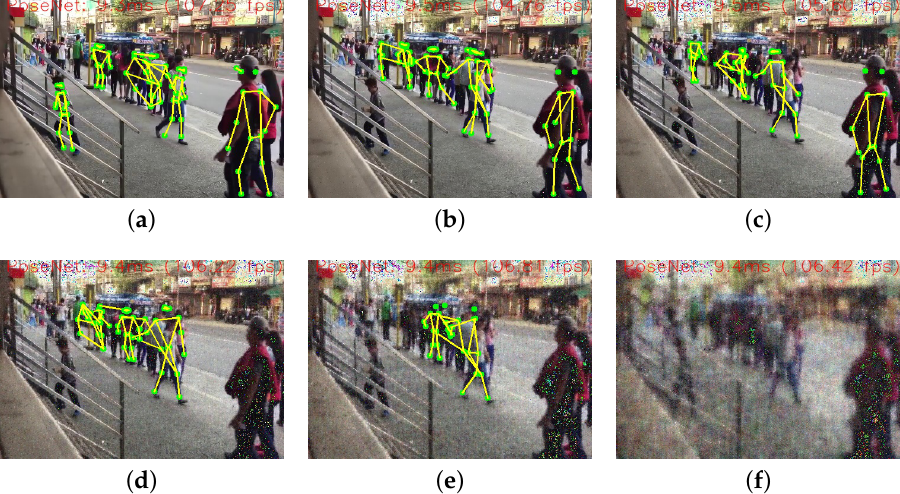
Figure 5. Outputs of the PoseNet model for video resolution of 480 × 360: ( a ) original image, ( b ) CS